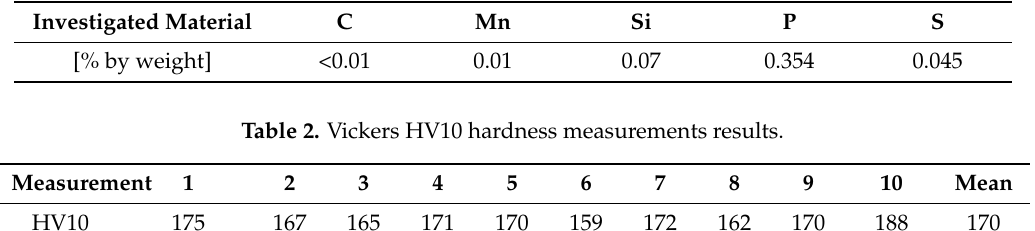
Table 2. Vickers HV10 hardness measurements results.